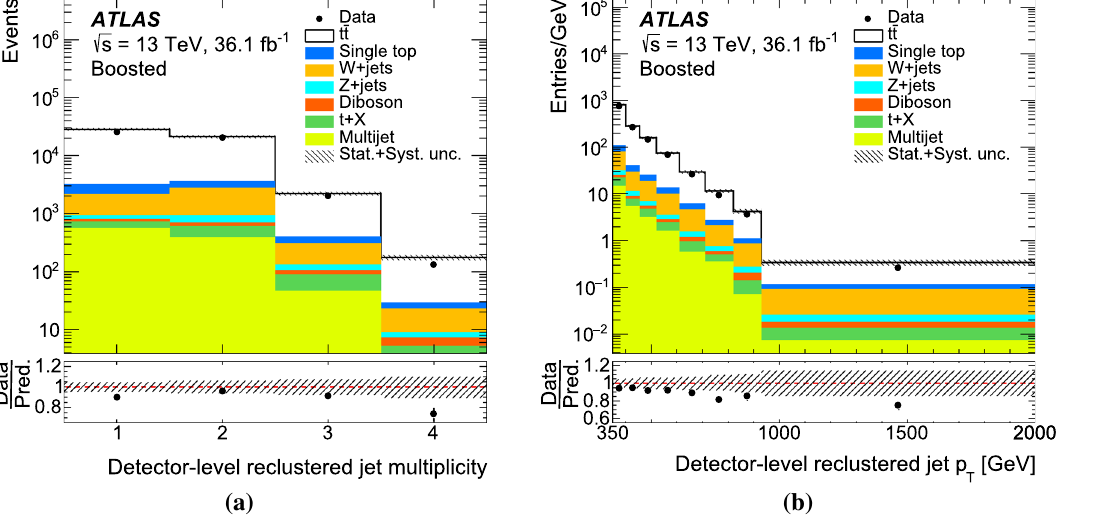
Fig. 3 Kinematic distributions in the (cid:3) + jets channel in the boosted topology at detector-level: a number of reclustered jets and b reclus- tered jet p T . Data distributions are compared with predictions using Powheg + Pythia8 as the t ¯ t signal model. The hatched area repre- sents the combined statistical and systematic uncertainties (described